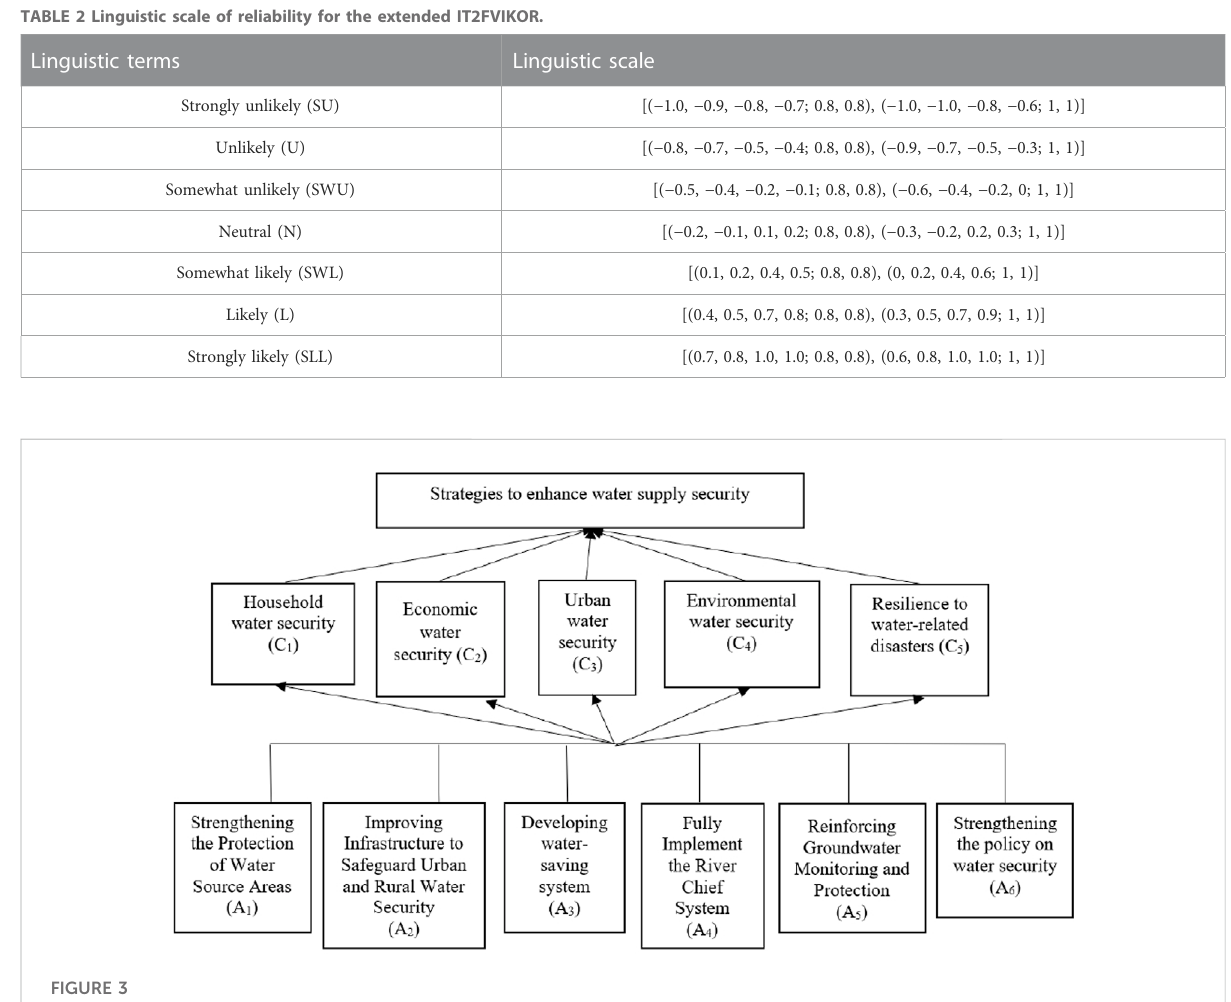
FIGURE 3 Water security decision attributes